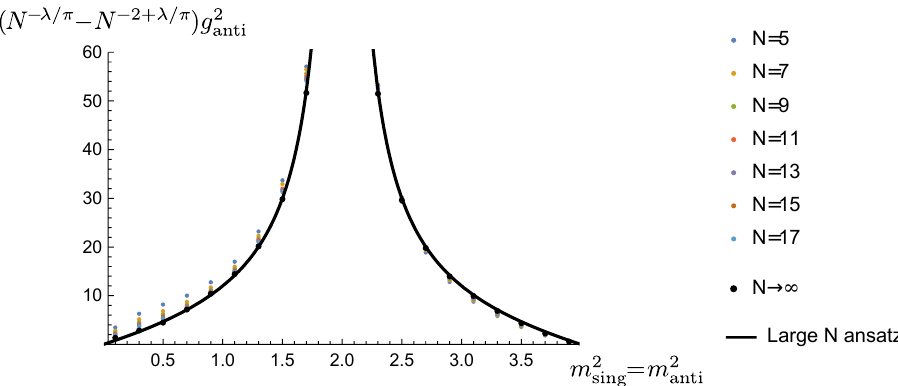
Figure 14 . Comparison between the (cid:12)nite N numerics and the large N analysis for two equal mass bound states in the singlet and anti-symmetric representations. The maximum couplings are rescaled by the power of N in (4.19). The (cid:12)nite N results in (cid:12)gure 10 (coloured points) are extrapolated to N ! 1 (black dots) and compared to the large N result (4.19) (solid black